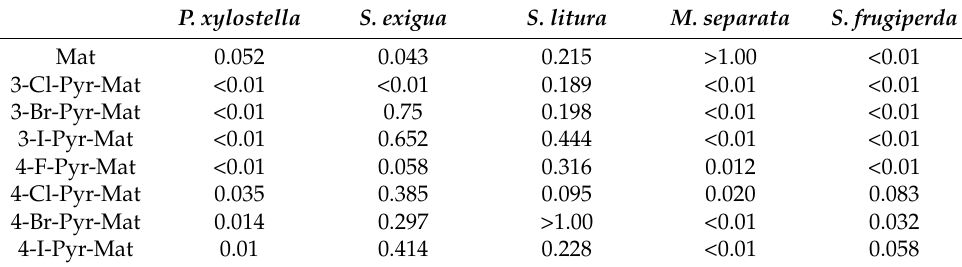
Table 2. Toxicities of matrine and its derivatives to agricultural pests.